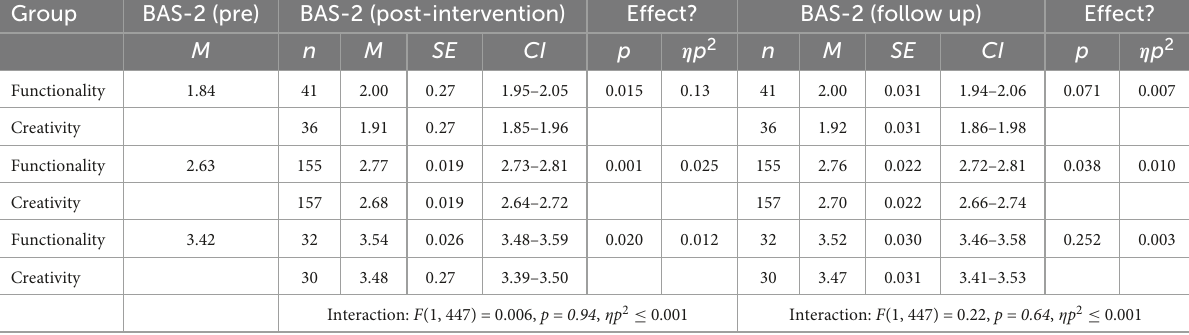
TABLE 4 Summary of intention-to-treat (ITT) analysis for body appreciation (BAS-2), including estimated marginal means and effects of the intervention at baseline values of BAS-2 one-standard deviation below the mean, the mean, and one-standard deviation above the mean, as well as the interaction effect (baseline BAS-2 and study arm) on BAS-2 at post-intervention and 1-month follow up ( N = 451). Group BAS-2 (pre)